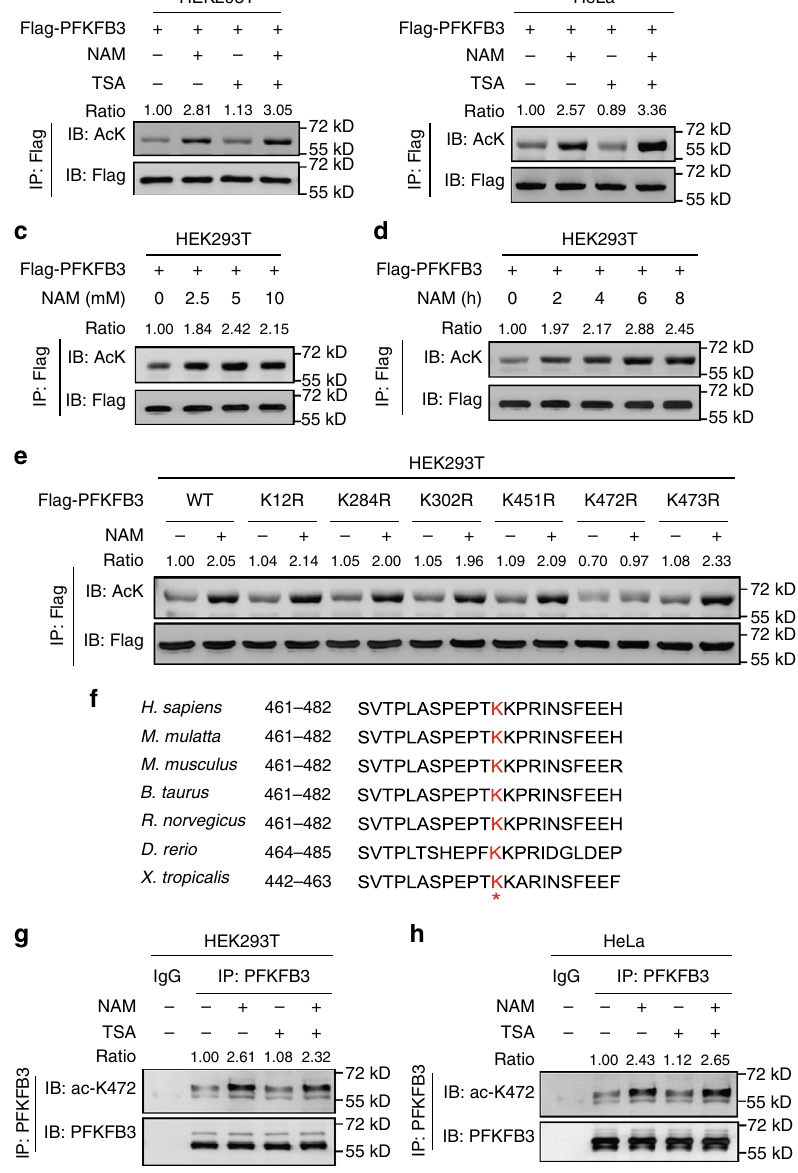
Fig. 2 PFKFB3 is acetylated at K472. a , b Acetylation of PFKFB3 was increased by deacetylase inhibitors. Flag-tagged PFKFB3 was ectopically expressed in a HEK293T and b HeLa cells. Cells were treated with NAM, TSA or both for the duration indicated. Flag-PFKFB3 was immunoprecipitated from cell lysate and its acetylation was examined with a pan-acetylated lysine antibody ( α -AcK). Relative PFKFB3 acetylation was normalized by Flag protein. c , d Acetylation level of PFKFB3 was increased by NAM treatment in a dose- and time-dependent manner. Flag-tagged PFKFB3 was ectopically expressed in HEK293T cells. Cells were treated with NAM at the indicated concentrations for 6h ( c ), or treated with 5 μ M NAM for the duration indicated ( d ). Flag-PFKFB3 was immunoprecipitated and its acetylation was examined with α -AcK. e K472 is the major acetylation residue of PFKFB3. Flag-tagged WT PFKFB3 or mutants (K12R, K284R, K302R, K451R, K472R, and K473R) were expressed in HEK293T cells, followed by treatments with or without 5 μ M NAM. Flag-PFKFB3 was immunoprecipitated and its acetylation was examined with α -AcK. f K472 in PFKFB3 is evolutionarily conserved in vertebrates. Alignment of the sequences around PFKFB3 K472 from different species is shown. g , h Endogenous PFKFB3 is acetylated at K472. Endogenous PFKFB3 protein was puri fi ed from HEK293T or HeLa cells after NAM and TSA treatment as indicated. Acetylation of K472 was examined with an antibody speci fi cally recognizing the acetylated K472 residue of PFKFB3 ( α - acK472). Relative PFKFB3 K472 acetylation was normalized by PFKFB3 protein. Data are representative of three independent